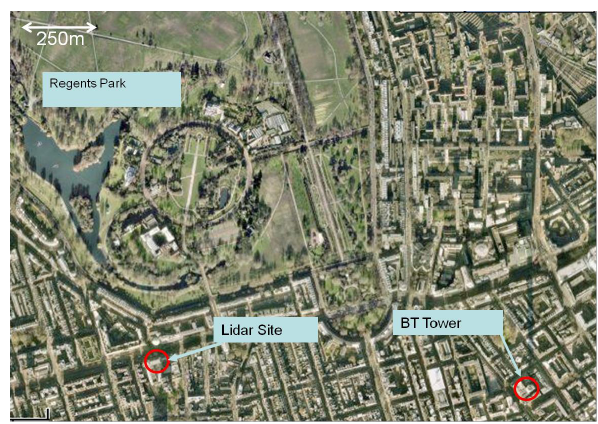
Fig. 1. Site of Doppler lidar and BT Tower sonic anemometer Figure 1. Site of Doppler lidar and BT Tower sonic anemometer during the REPARTEE during the REPARTEE campaign in central London, UK, in Oc- campaign tober/November